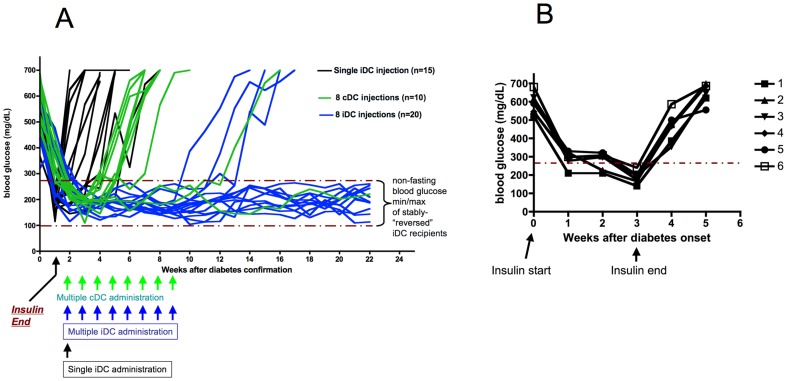
Stable reversal of T1D in NOD mice is achieved by multiple iDC injections.a. Multiple iDC injections (n = 8, blue lines) stably maintain glucose levels within a range between 100–280 mg/dL in most new-onset T1D NOD mice. Multiple control DC injections (n = 8, green lines) reversed T1D in a few recipients, albeit transiently. Single iDC injections (black lines), compared to multiple injections were ineffective in restoration of blood glucose stability. The lines represent non-fasting blood glucose levels in individual NOD mice. Mice were first administered insulin once diabetic hyperglycemia was confirmed until the time glucose levels dropped to below 280 mg/dL (5–8 days on average). At this point, insulin was withdrawn. Then, 2×106 DC (cDC or iDC) were injected s.c at the abdominal flank overlying the gastrointestinal organs. Time 0 represents the time of diabetes confirmation. The black arrow below the x-axis shows the time of insulin withdrawal concomitant with the first DC injection. The coloured arrows show the times at which DC were administered (single or multiple). The dashed lines in the graph indicate the minimum and maximum non-fasting blood glucose levels measured in the reversed iDC treatment group. b. Blood glucose crosses the 280 mg/dL threshold within a day of insulin withdrawal when new-onset diabetic NOD mice (n = 5) are not subjected to any other treatment. These data indicate that insulin administration alone cannot account for the effects of cDC or iDC in prolonging normoglycemia in NOD mouse cohorts shown in Figure 1a.